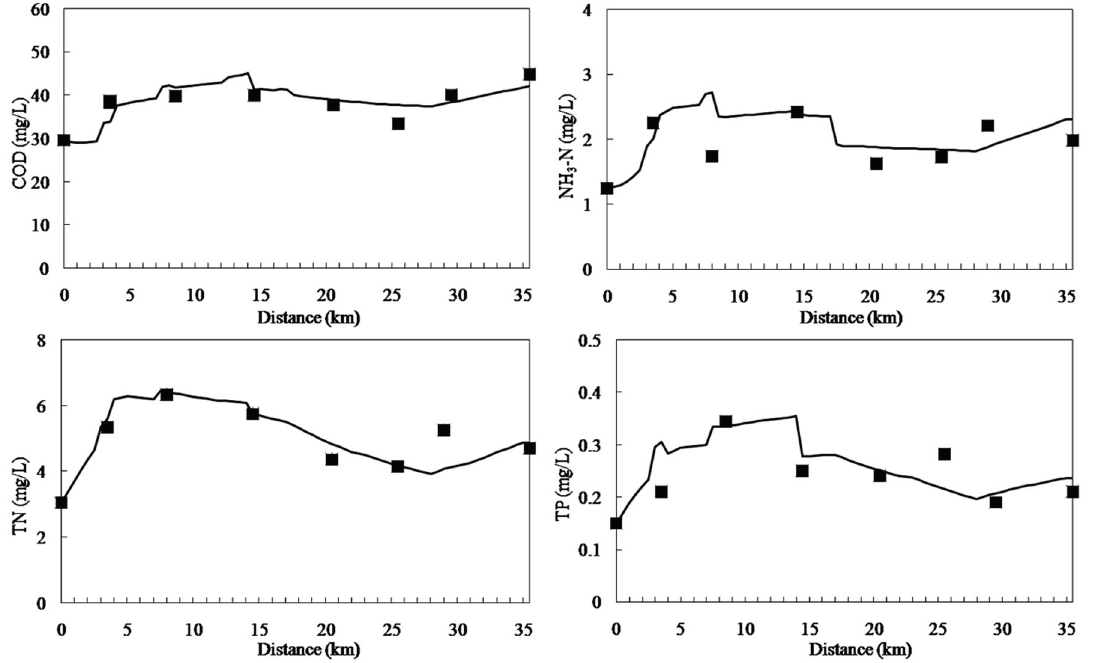
Figure 3. Water quality calibration results for the Wujin River.